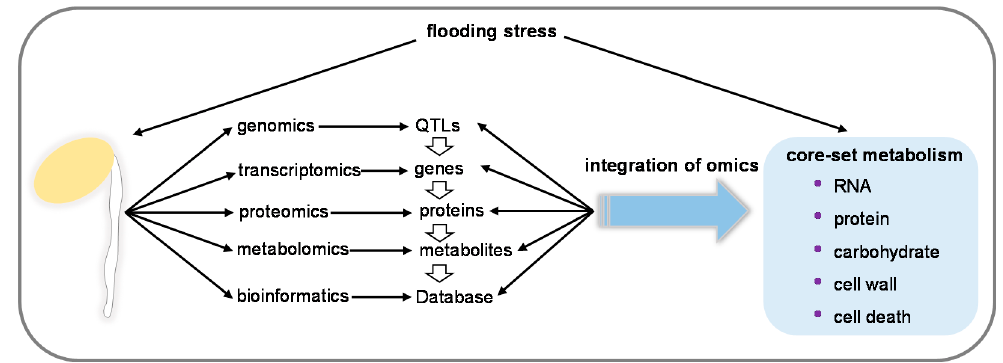
Figure 2. Overview of plant omics findings in response to flooding in soybean. Quantitative trait loci (QTLs), genes, proteins, and metabolites that are related to flooding stress were identified through genomics, transcriptomics, proteomics, and metabolomics, respectively. Soybean Proteome Database was constructed by bioinformatic analysis of omics data. Integration of soybean omics highlighted core set of flooding metabolisms in soybean.